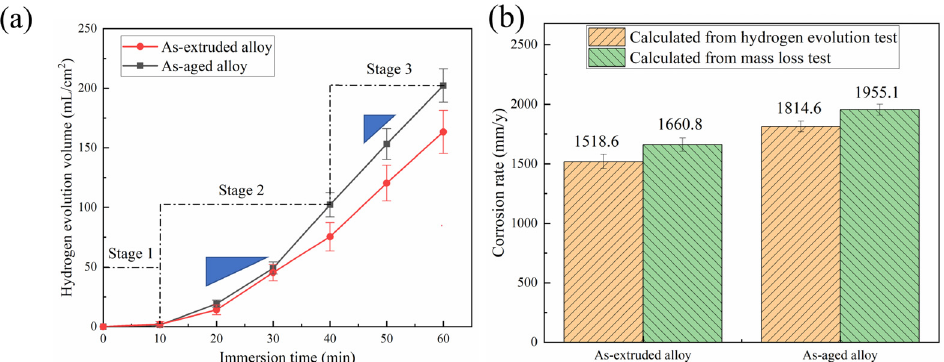
Figure 5. Hydrogen evolution curves ( a ) and corrosion rates ( b ) of the Mg–6.0Gd–1.2Cu–1.2Zr alloy immersed in 3 wt.% KCl for 60 min.